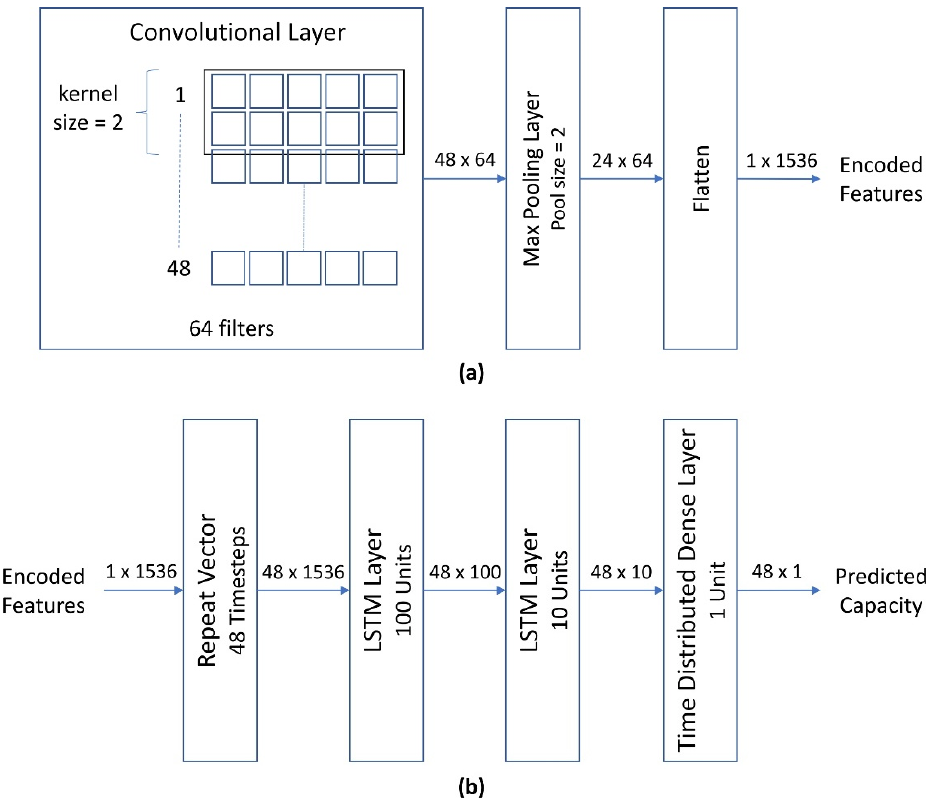
Figure A1 . Architecture of the forecasting model. A convolutional neural network was used to encode the input ( a ), which was decoded using a stacked-LSTM network ( b ).